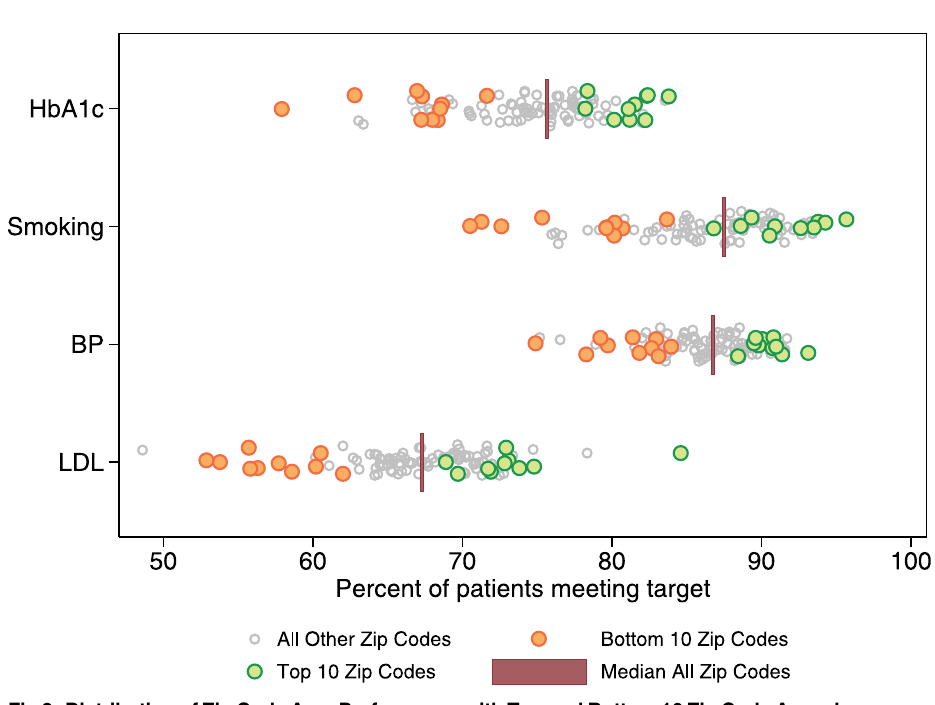
Fig 2. Distribution of Zip Code Area Performance with Top and Bottom 10 Zip Code Areas by Summary Score.